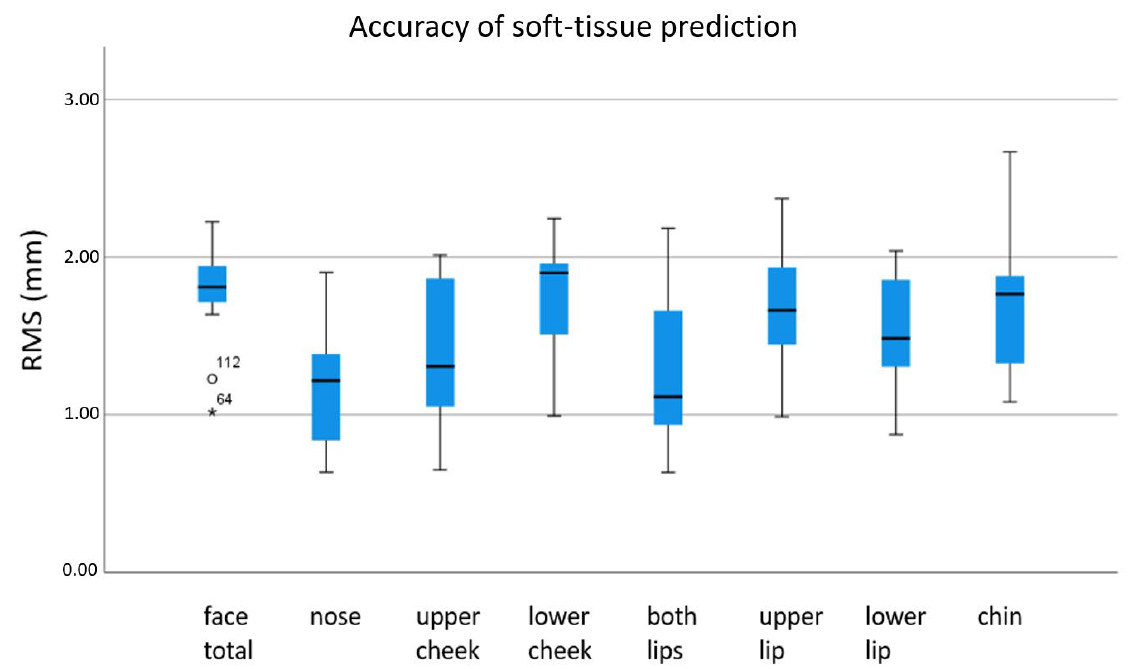
Figure 5. Unsigned mean absolute discrepancy between postoperative 3D scan and preoperative soft-tissue simulation. ◦ : moderate outlier: 1.5–3.0 × IQR (interquartile range); *: extreme outlier: >3.0 × IQR.